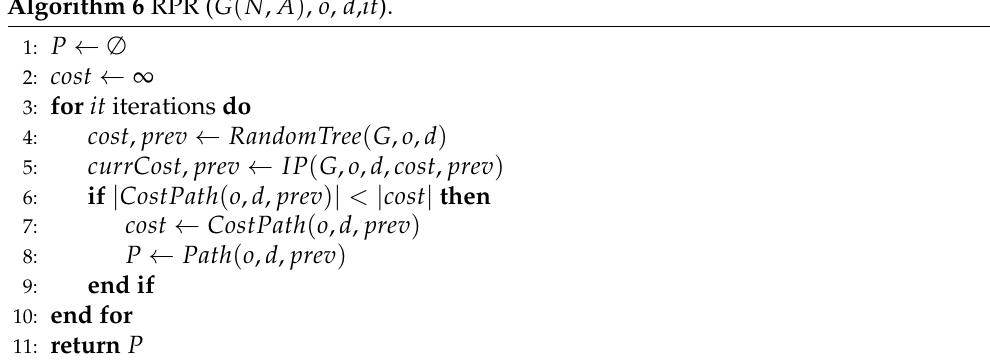
Algorithm 6 RPR ( G ( N , A ) , o , d , it